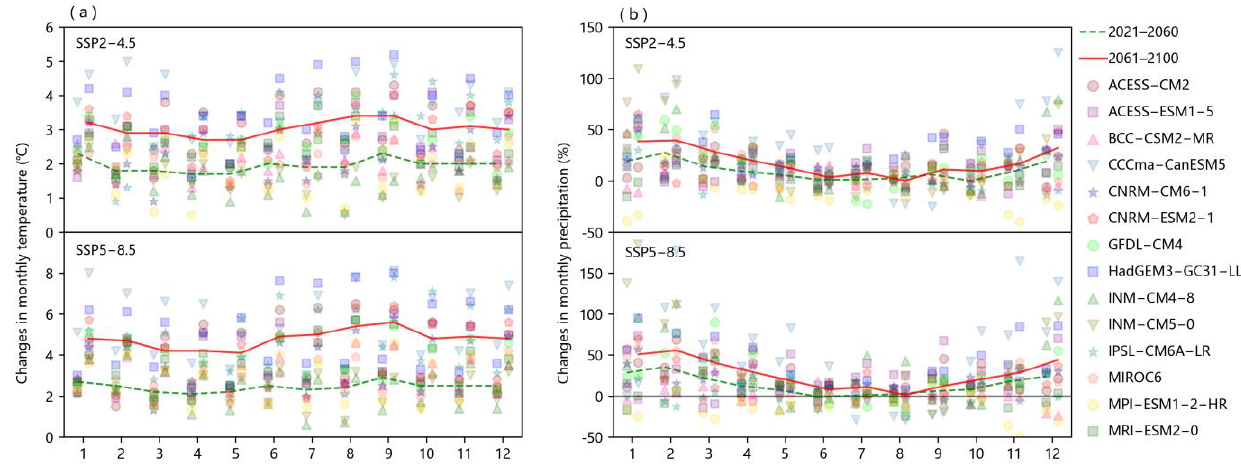
Figure 4. Projected changes in ( a ) monthly average temperature and ( b ) monthly precipitation